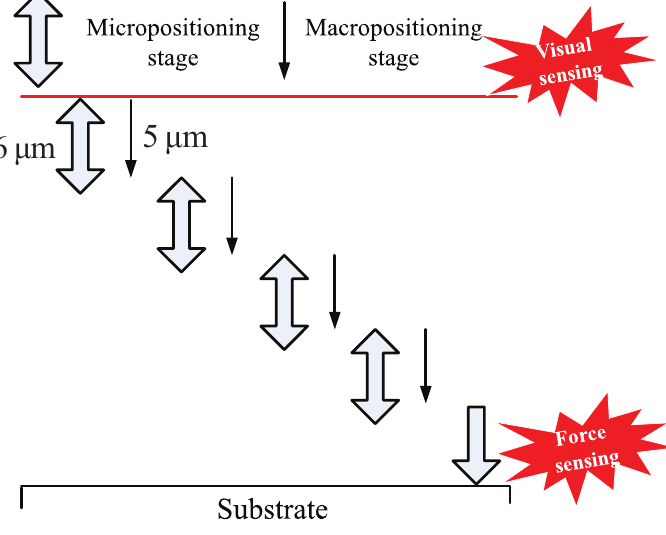
Figure 11. The approaching method using visual and force-displacement